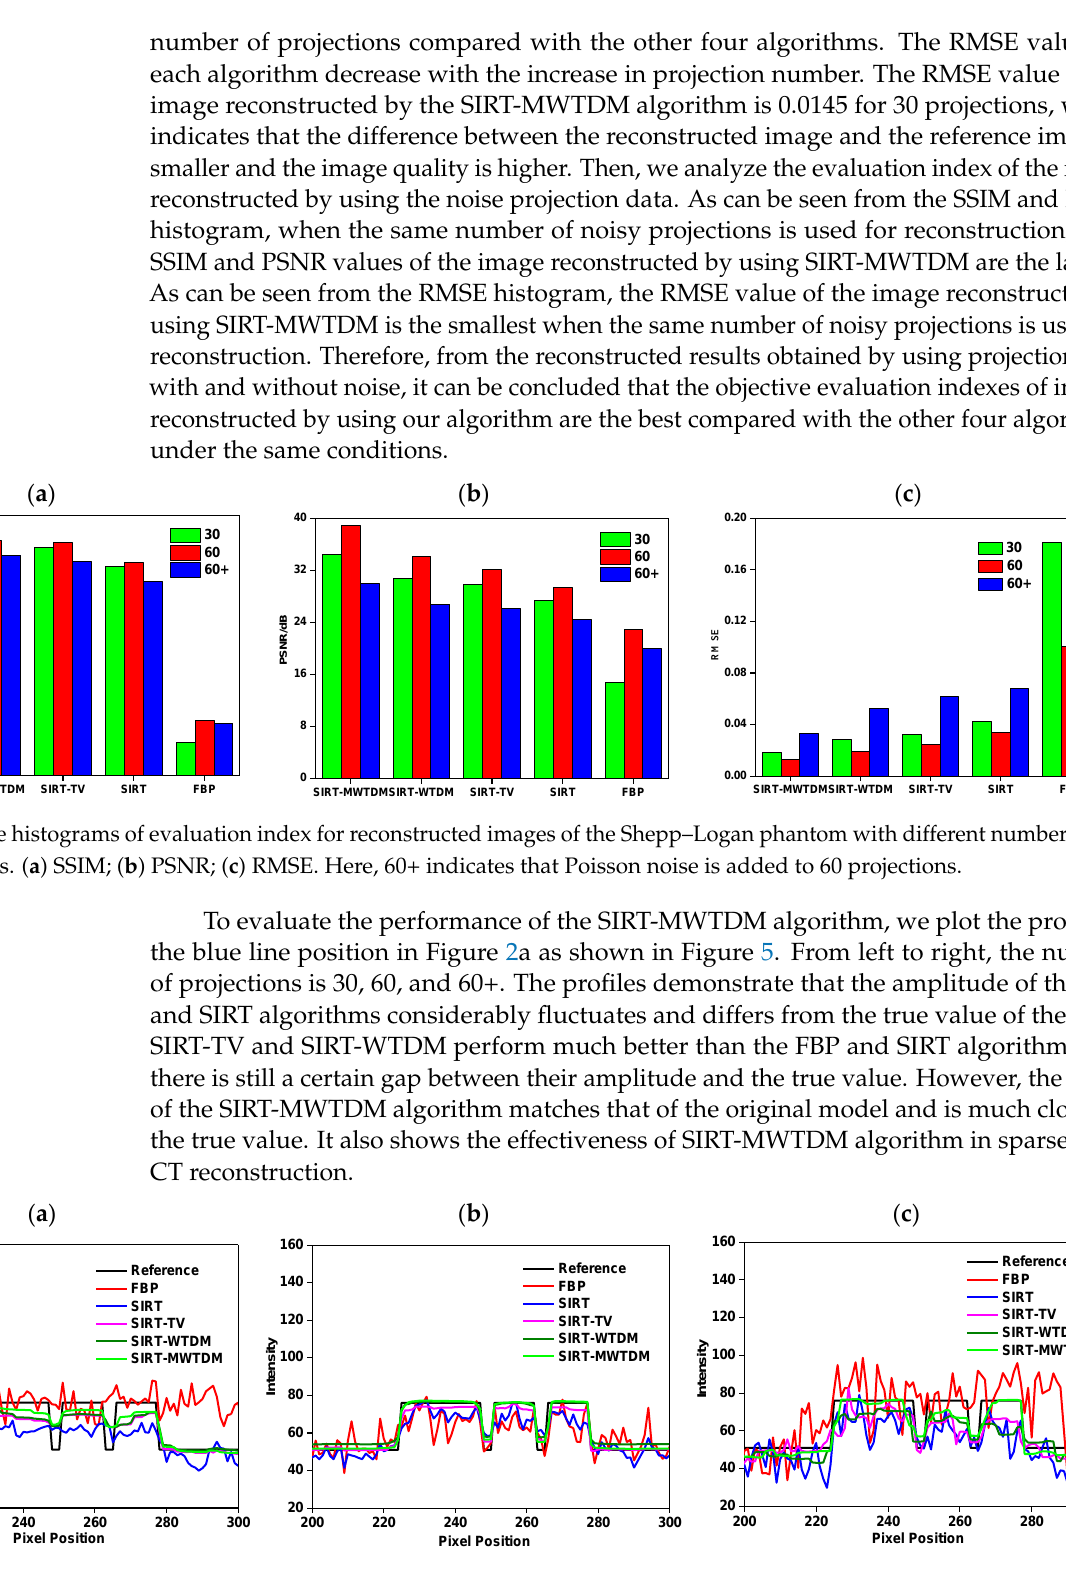
Figure 5. The profile of the blue line position in Figure 2a. The number of projections is ( a ) 30; ( b ) 60; ( c ) 60+. Here, 60+ indicates that Poisson noise is added to 60 projections.